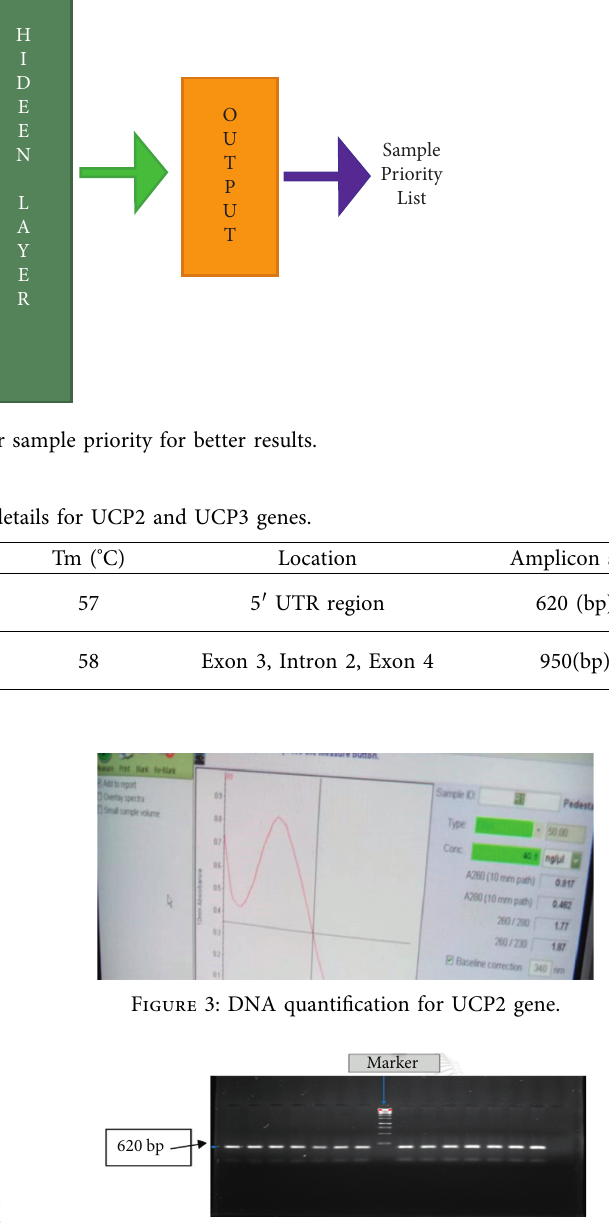
Figure 4: Amplified PCR product of the UCP2 gene.